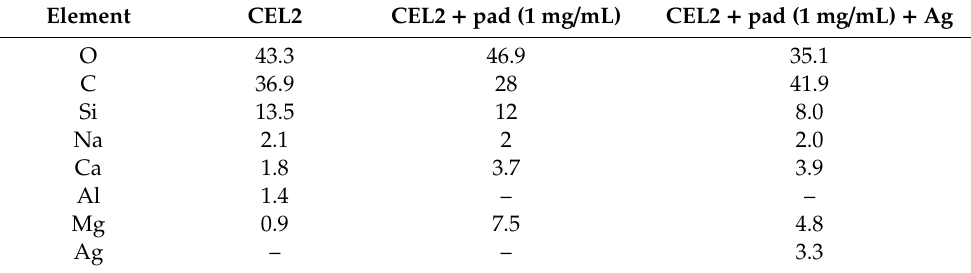
Table 3. Atomic percentages of elements from XPS survey